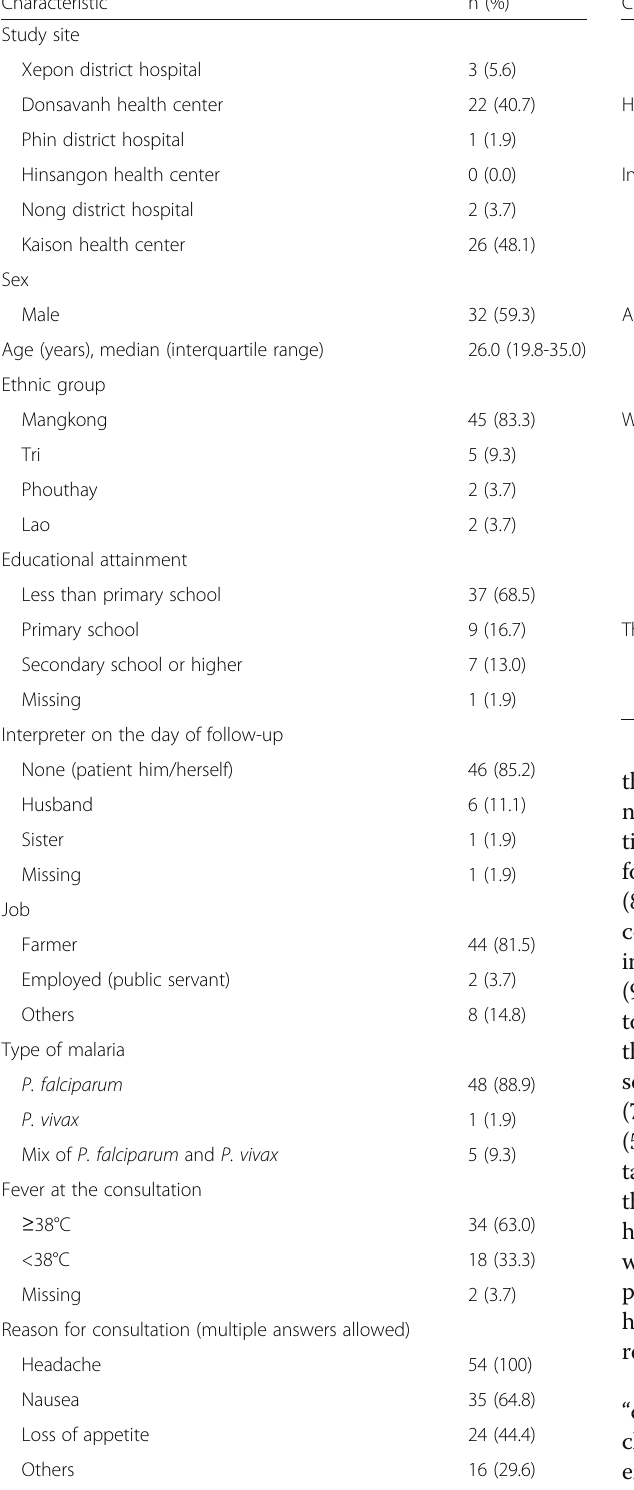
Table 1 Socio-demographic and patient characteristics in the patient study (n=54) (Continued)